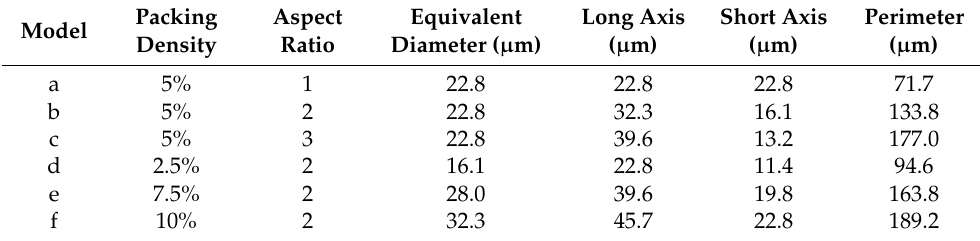
Figure 2. Schematic of computational domain of six models ( a – f ) in Table 1. Table 1. Parameters of the simulation models.